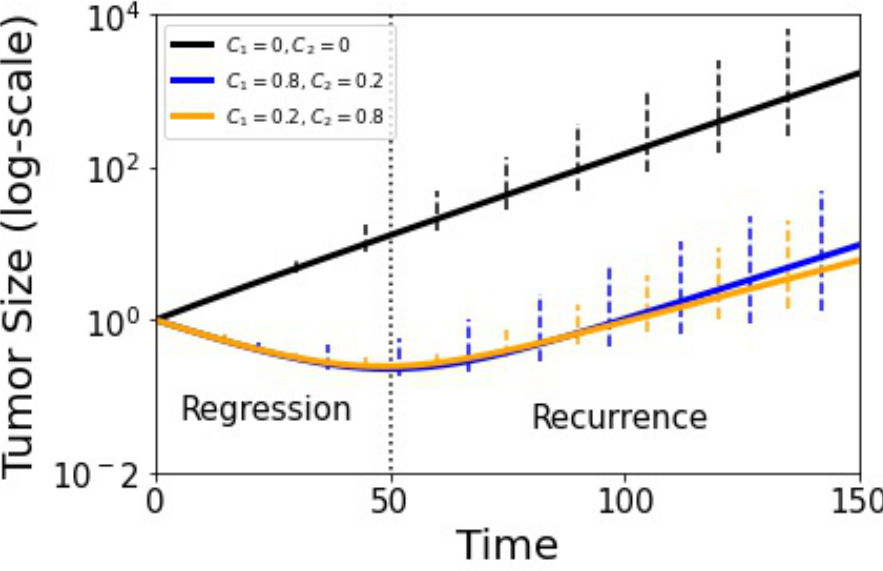
Figure 8. Tumor growth curve with adjusted replicator model using g = 1.05 and the stochastic Moran process model (100 runs). The black curve shows untreated growth, blue and yellow show adaptive therapy results. Error bars indicate 90% confidence level. Tumor recurrence sets in at t ≈ 50 in dimensionless time